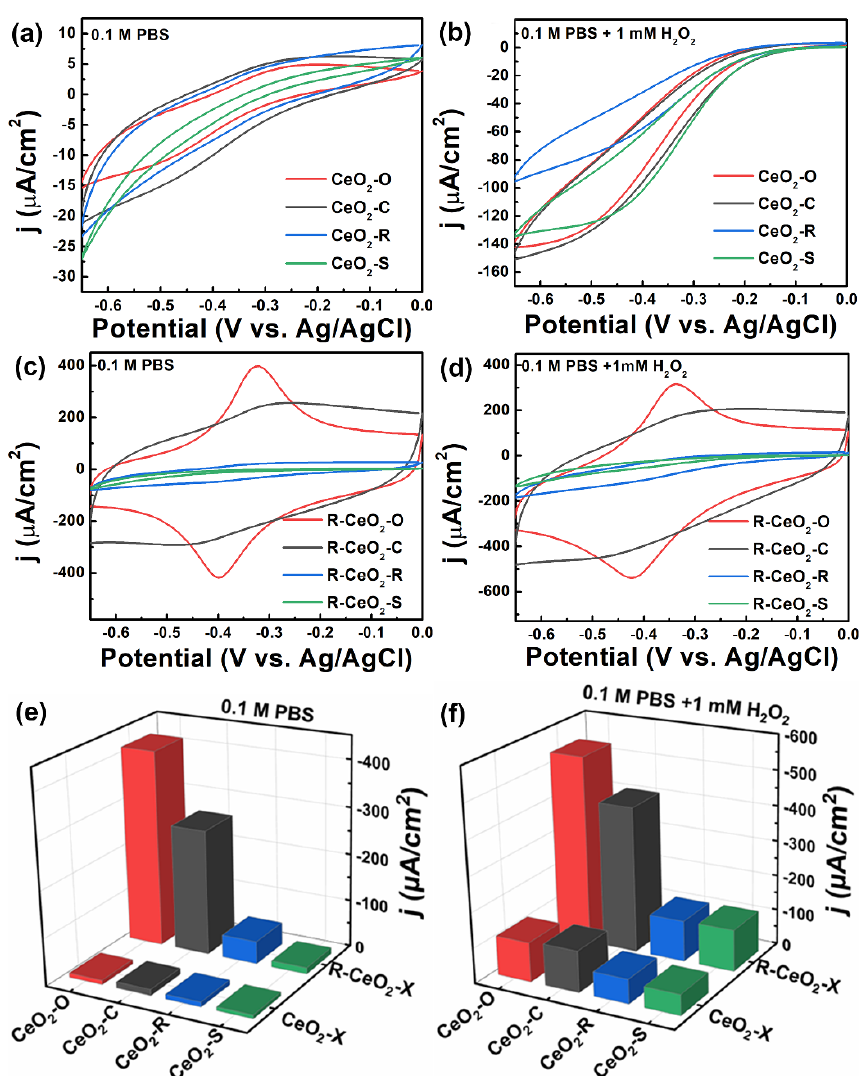
Figure 4. CV curves of CeO 2 -X samples in N 2 -saturated 0.1 M PBS containing ( a ) 0 mM and ( b ) 1 mM H 2 O 2 ; CV curves of R-CeO 2 -X samples in N 2 -saturated 0.1 M PBS containing ( c ) 0 mM and ( d ) 1 mM H 2 O 2 . 3D histograms of reduction peak currents for CeO 2 with four different morphologies before and after reduction in N 2 -saturated 0.1 M PBS containing ( e ) 0 mM and ( f ) 1 mM H 2 O 2 .